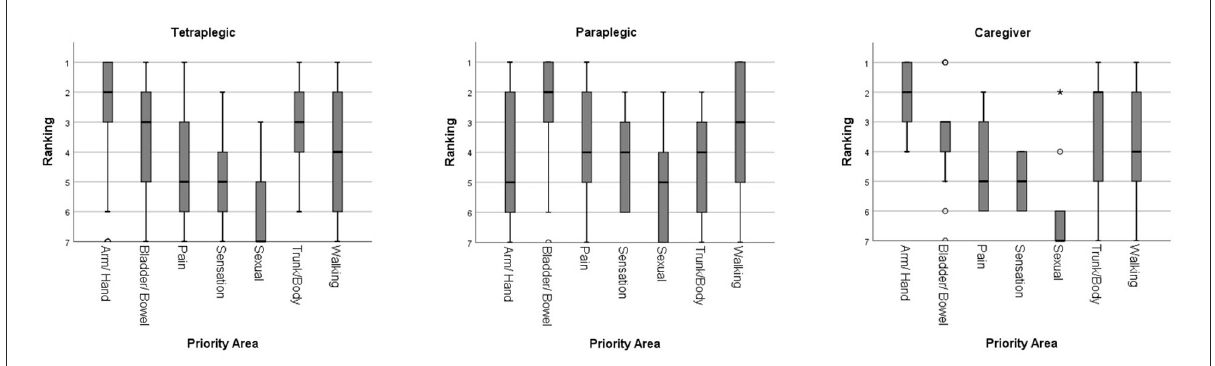
FIGURE1 Overall rankings of the priority areas of functional recovery.